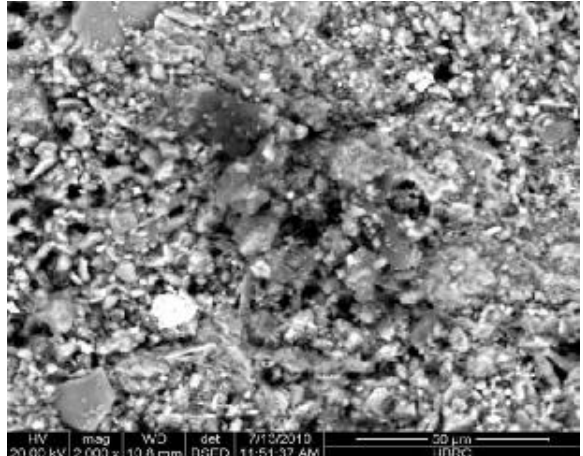
Figure 4: The Examination of the second sample with SEM